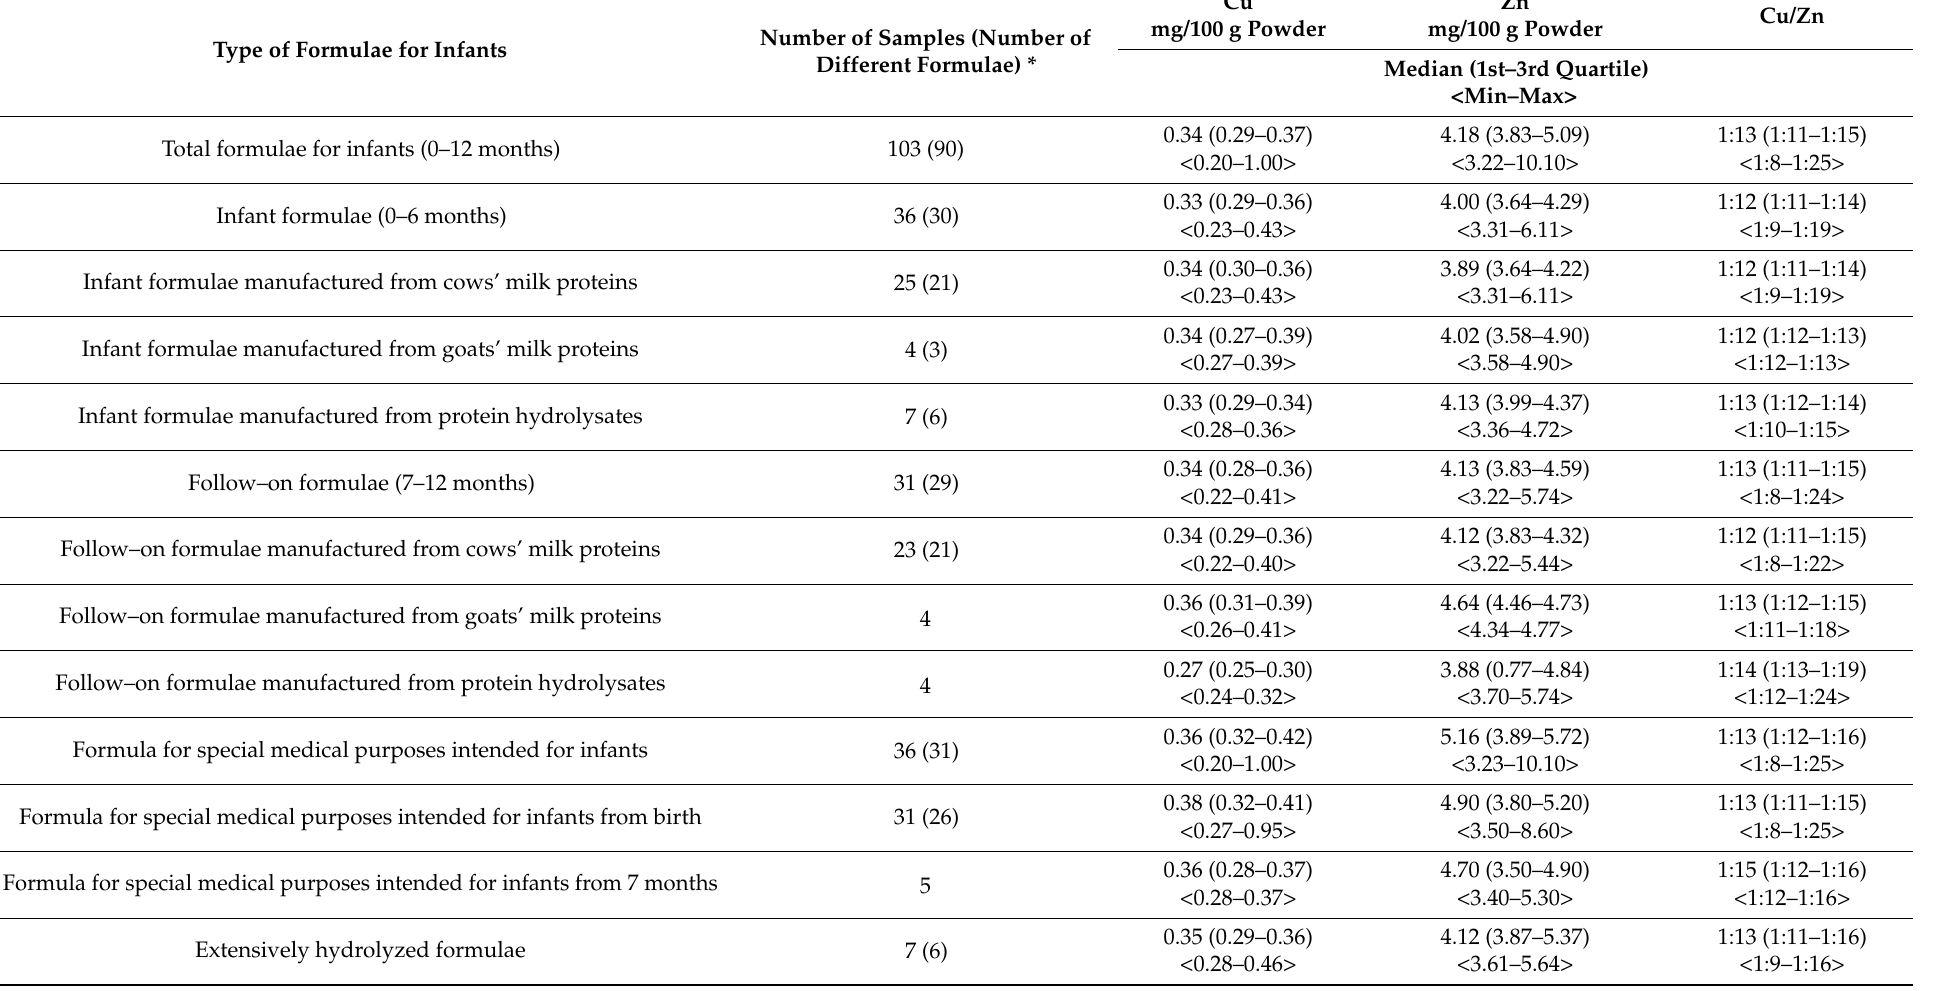
Table 1. Copper and Zinc concentration (mg/100 g powder) in different types of formula for